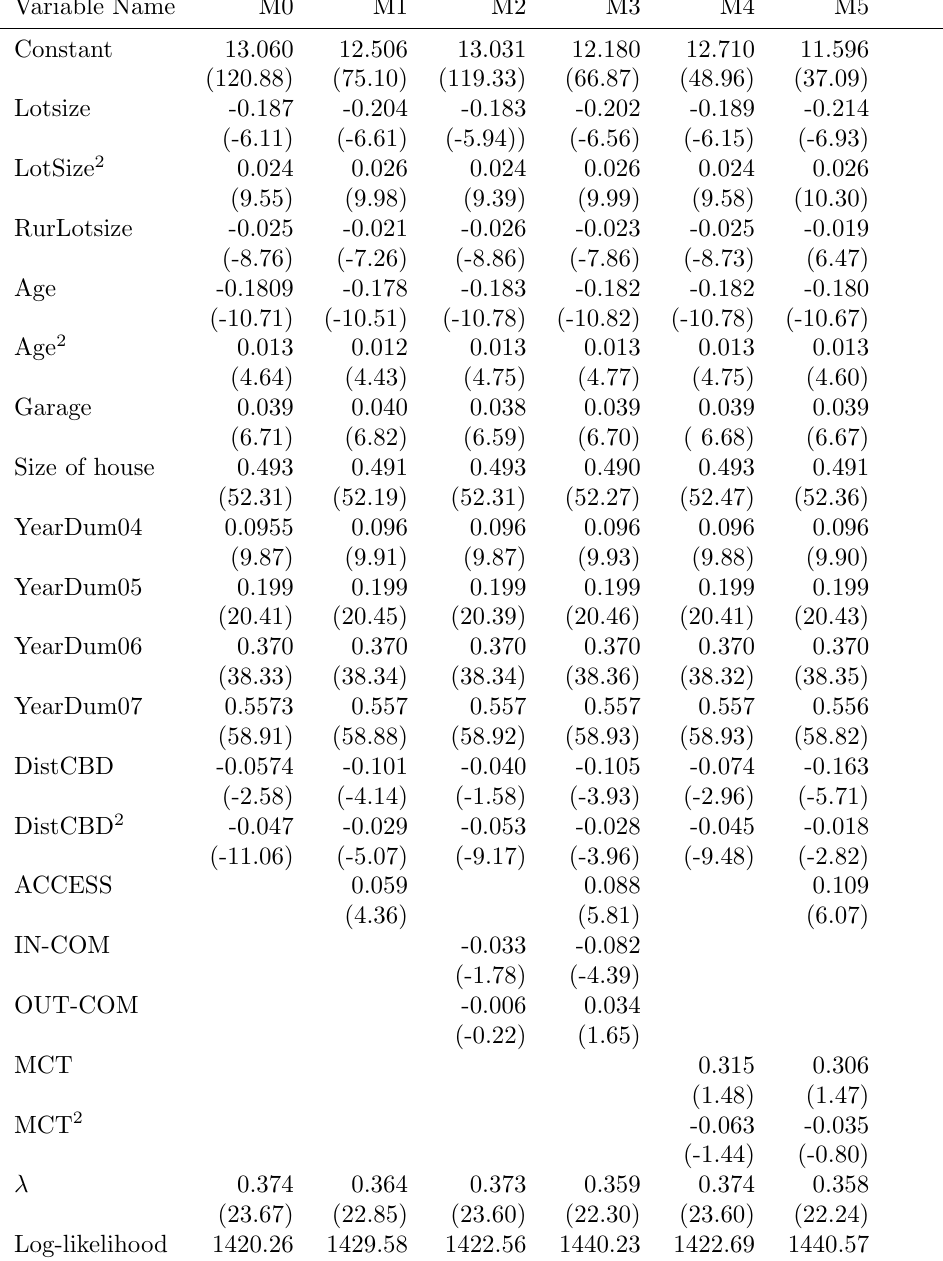
Table A.1: Estimated results for the hedonic house price models based on the spatial error model formulation as specified in equation